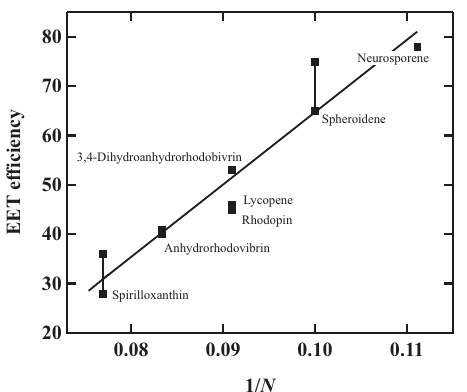
Fig. 1 The relationship between the ef fi ciency of excitation energy transfer from carotenoid to Bchl a in the LH1 complex and the number of conjugated double bonds of the carotenoids. The linear relationship can be seen between the ef fi ciency of excitation energy transfer from carotenoid to Bchl a in the LH1 complex from Rsp. rubrum and the inverse of the number of conjugated double bonds (1/ N ) of the carotenoids 18,19